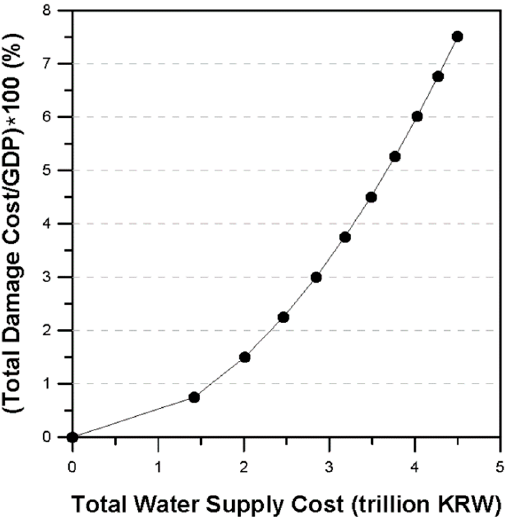
Figure 5. Relation between the total damage cost in the water-supply industry and the total water- supply cost for in 1995. supply cost for in